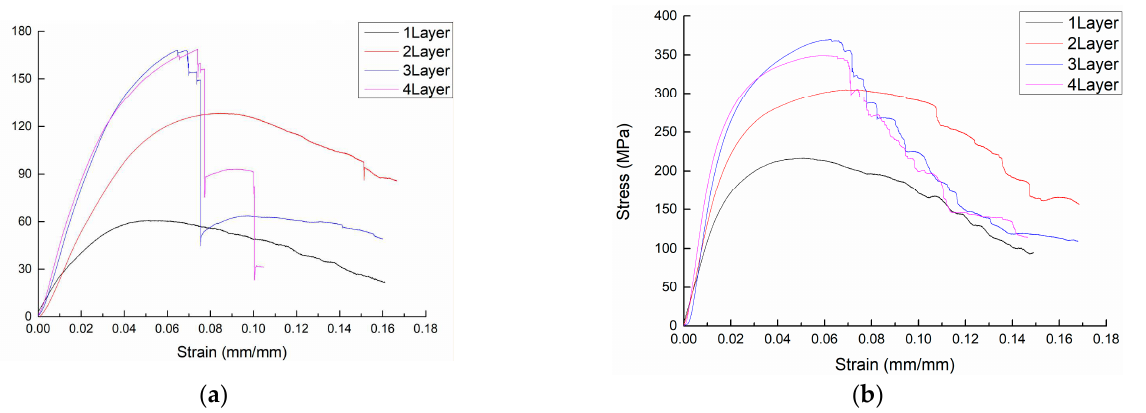
Figure 2. The bending stress-strain curve of 3DDAI Kevlar/EP armor materials with different stacking layers. ( a ) The warp direction. ( b ) The weft direction.